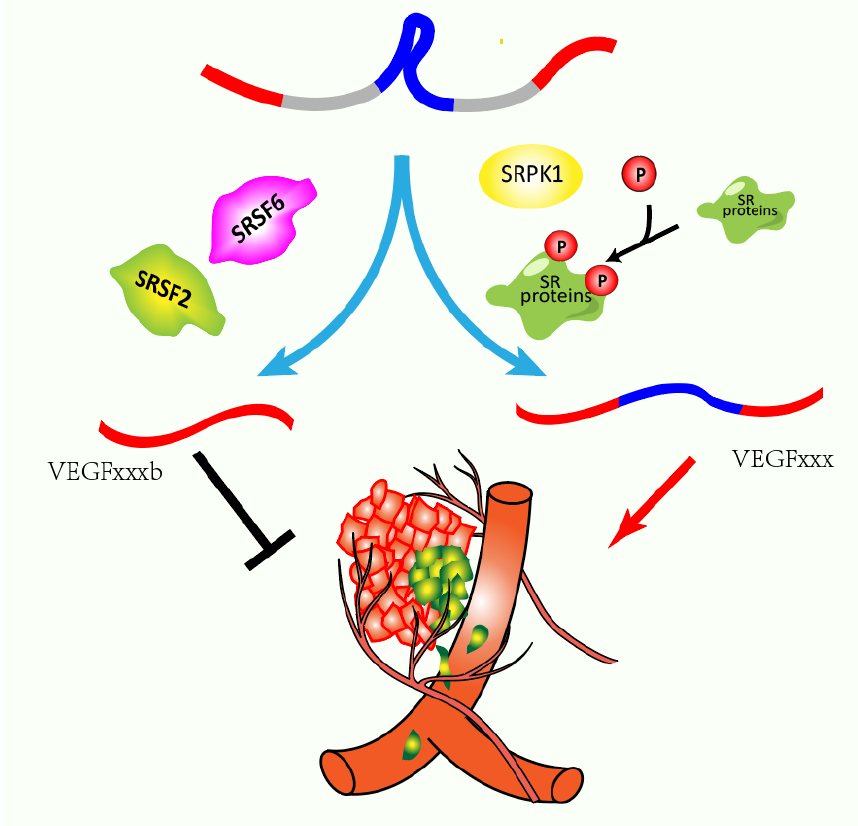
Figure 5. Co-regulation of SR proteins on common target through multiple mechanisms. As a contributor to angiogenesis, dysregulation of VEGF splicing contributes to cancer progression and is highly correlated with acquired drug resistance. For example, upregulated expression of SRSF2 or SRSF6, as a result of transcription increased or copy number amplified, is responsible for splicing in favor of VEGF165b, which is antagonistic to tumor neovascularization in vivo. However, overactivity of SRPK1 in the tumor could phosphorylate SRSF1 and stimulate its nuclear import, which favors the selection of the proximal splice site of VEGF pre-mRNA and promotes neovascularization.